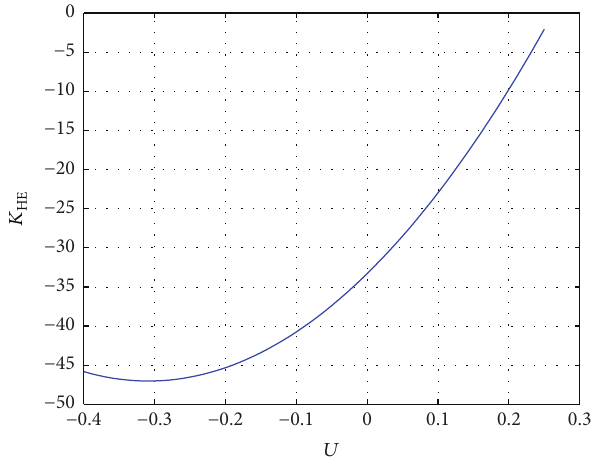
Algorithm 1: Algorithmic view of the Included Angle Dividing